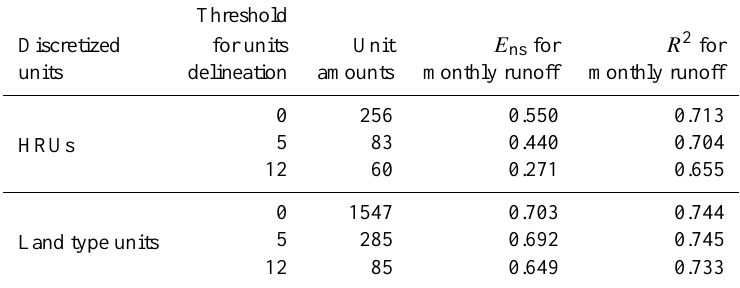
Table 4. Unit amounts and simulation results based on HRUs and land type